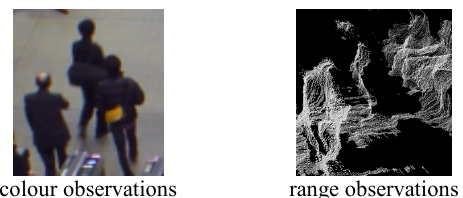
Figure 5. Example of the ground truth